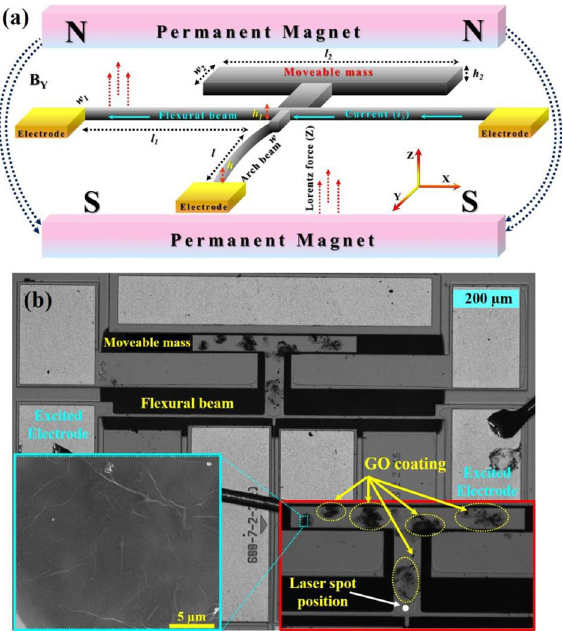
Figure 1. Device structure, ( a ) a schematic illustration of the device dimensions and setup for electro-magnetic actuation, ( b ) an optical image of the whole device. The inset shows a magnified image of the moveable mass. An SEM image (highlighted with light blue) is also shown to indicate the homogeneous distribution of GO sheet on the moveable mass surface.